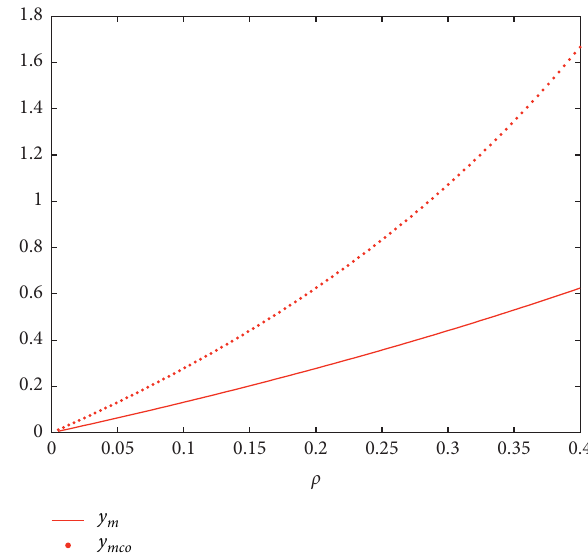
Figure 3: Profit comparison between decentralized and centralized decisions when θ changes.